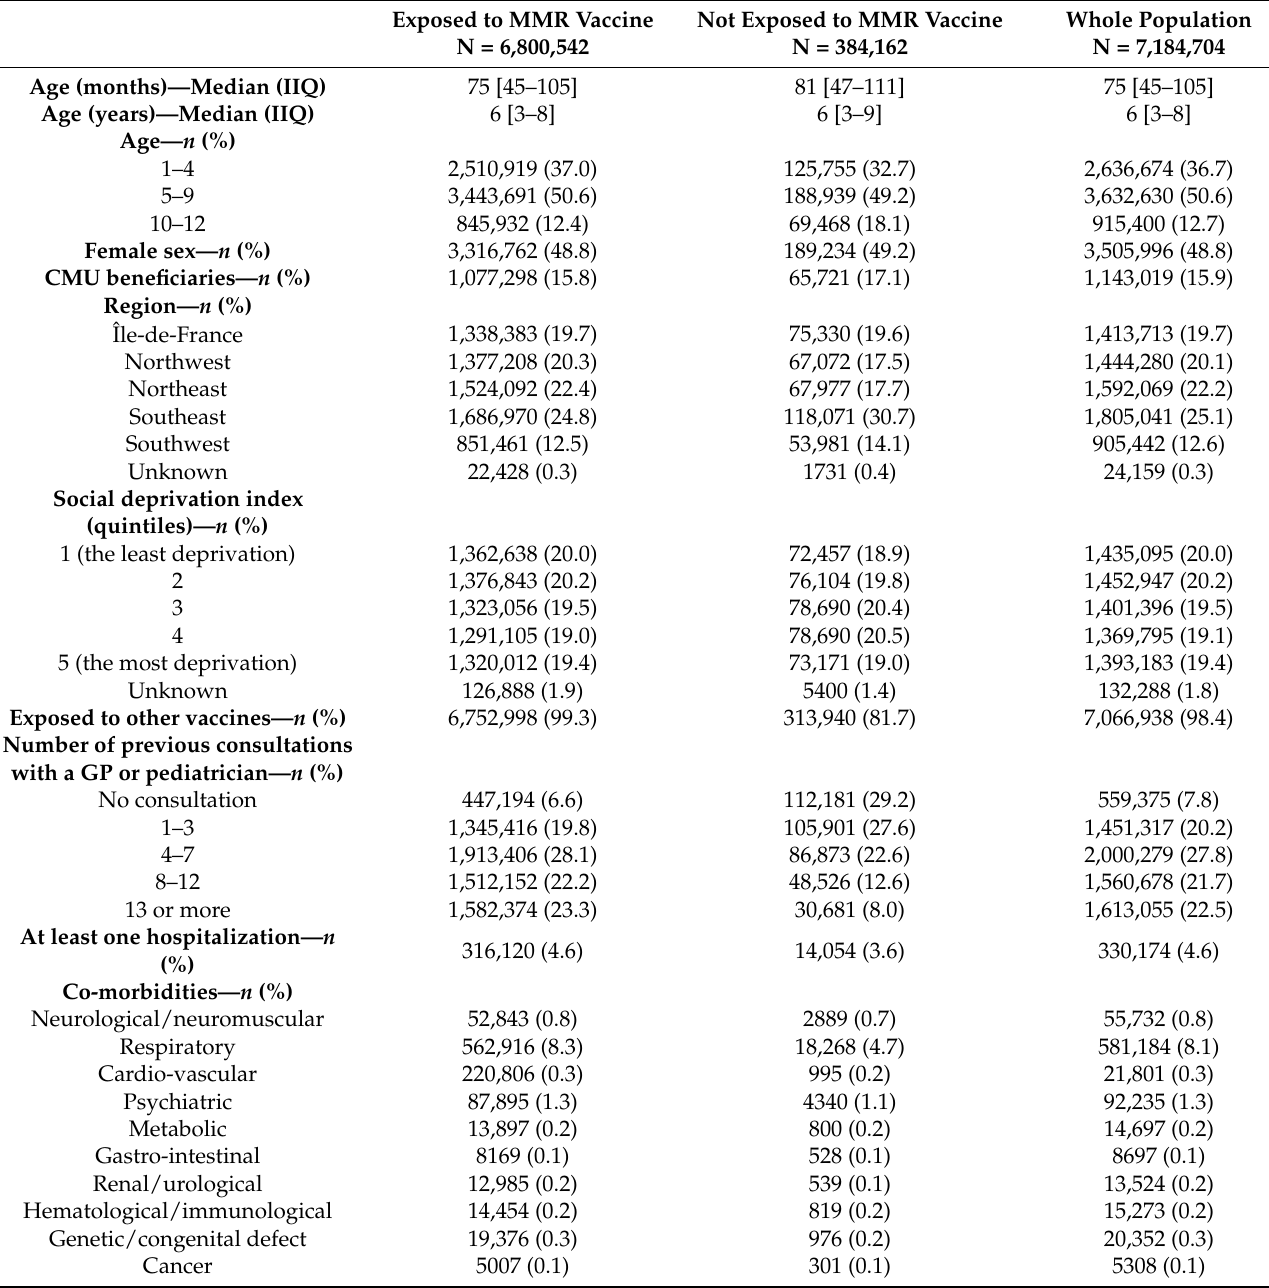
Table 1. Baseline characteristics according to MMR vaccine exposure